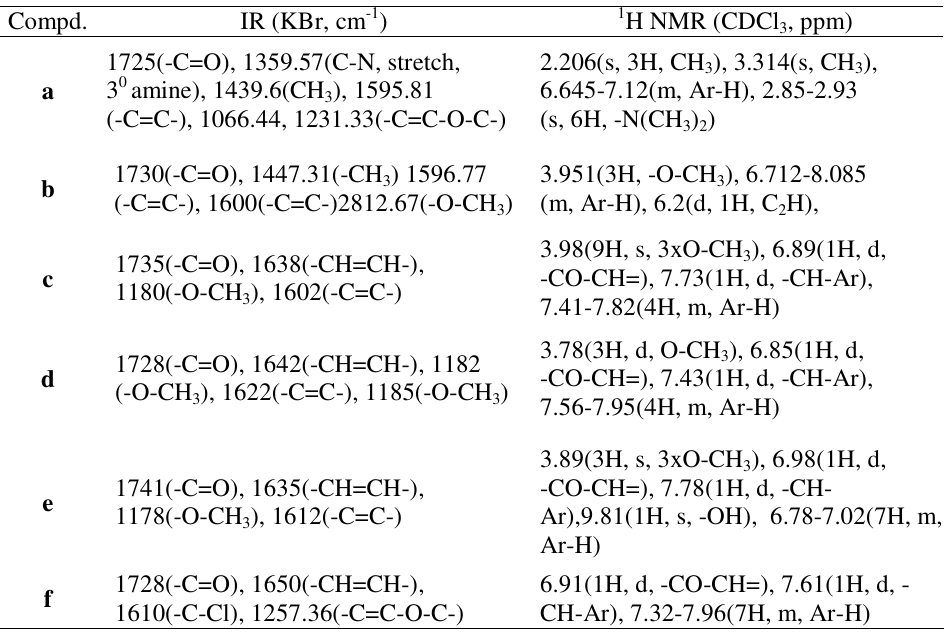
Table 2. Spectral data of the compounds ( a-f